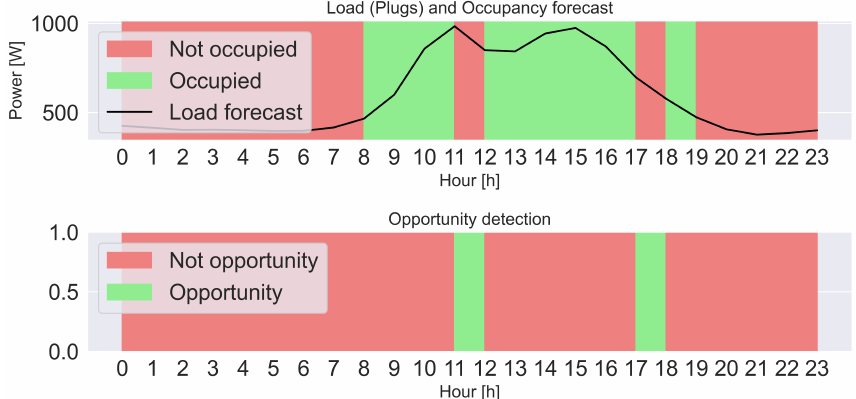
Figure 10. Behaviour Predictor plugs empty model opportunity detection on 2019-08-09.